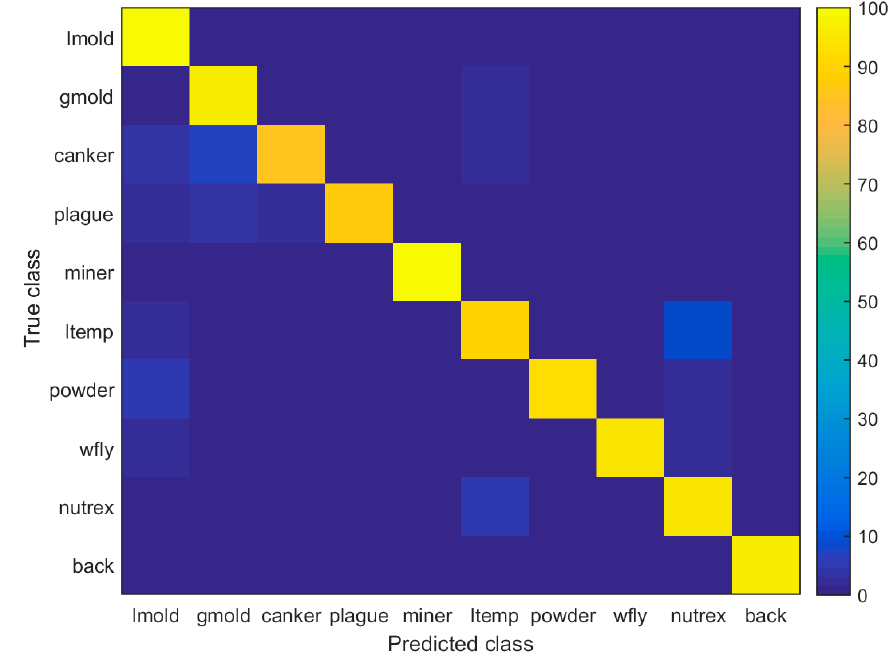
Figure 9. Confusion matrix of the Tomato Diseases and Pests detection results (including background, which is a transversal class containing healthy parts of the plants and surrounding areas, such as part of the greenhouse).